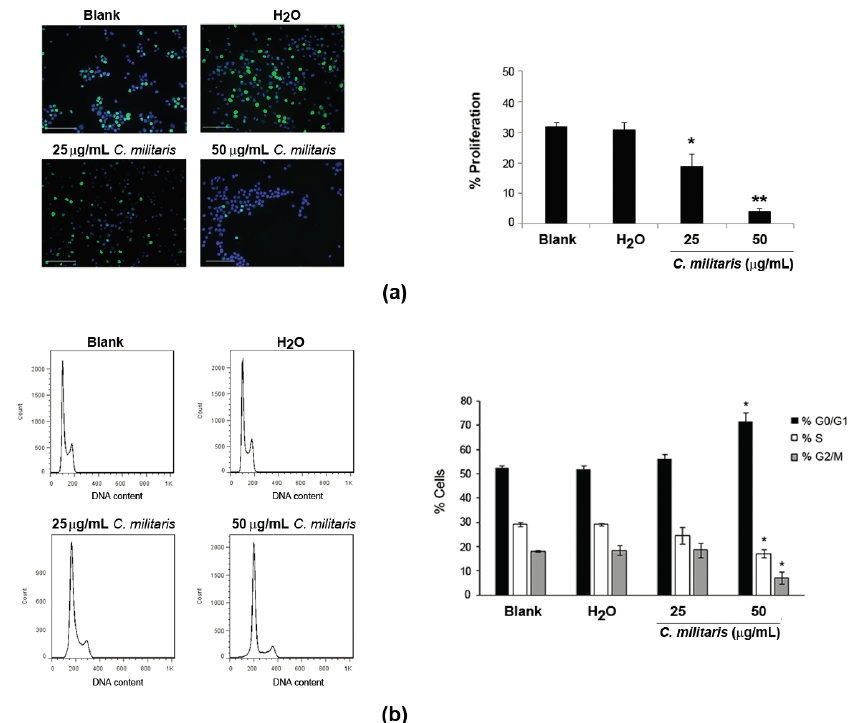
Figure 2. Effect of C. militaris methanolic fruiting body extract on NCI-H460 cellular proliferation ( a ); and cell cycle distribution ( b ). Cells were treated for 48 h with complete medium (Blank), 25 μ g/mL or 50 μ g/mL extract or with the highest vehicle (H 2 O) concentration. ( a ) Left panel: Representative fluorescence microscopy images of BrdU incorporation ( green ); and DAPI stained nuclei ( blue ). Bar corresponds to 20 μ m. Right panel: % of BrdU-incorporating cells; ( b ) Left panel: Representative cell cycle histograms. Right panel: Distribution of cells in cell cycle phase. Results are the mean ± SEM of, at least, three independent experiments. * p ≤ 0.05 and ** p ≤ 0.001 blank vs.